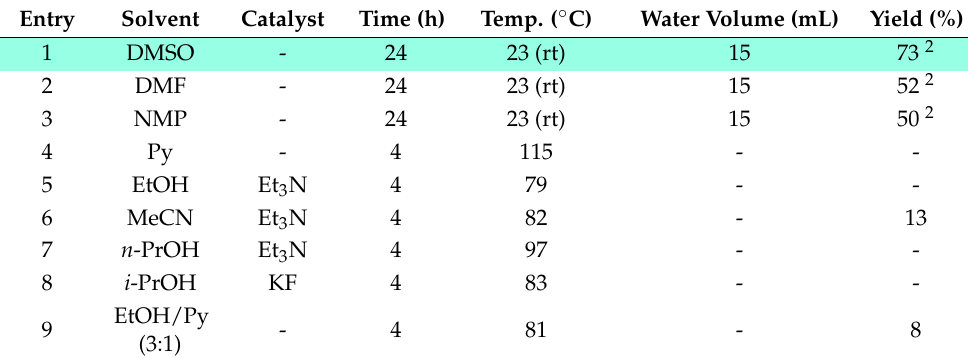
Table 1. Optimization of multicomponent reaction conditions 1